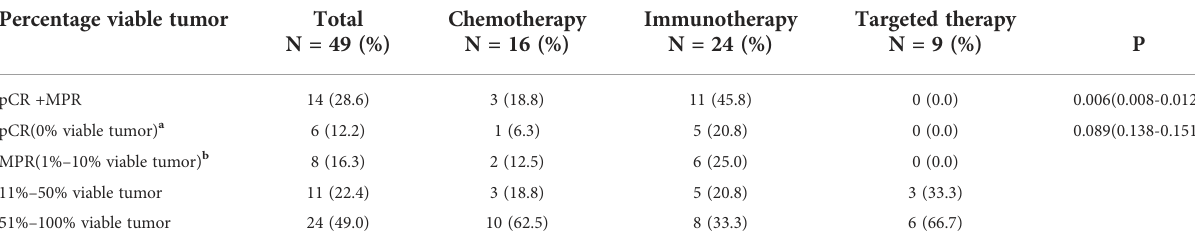
TABLE 4 Pathological response rates of operable locally advanced NSCLC patients in different neoadjuvant therapy groups after surgery. Percentage viable tumor Total Chemotherapy